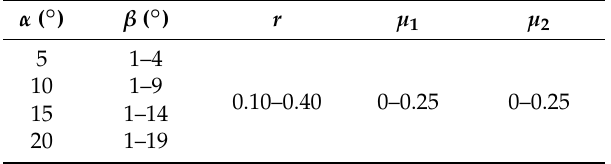
Table 2. Ranges of values used in the calculation of the total energy.